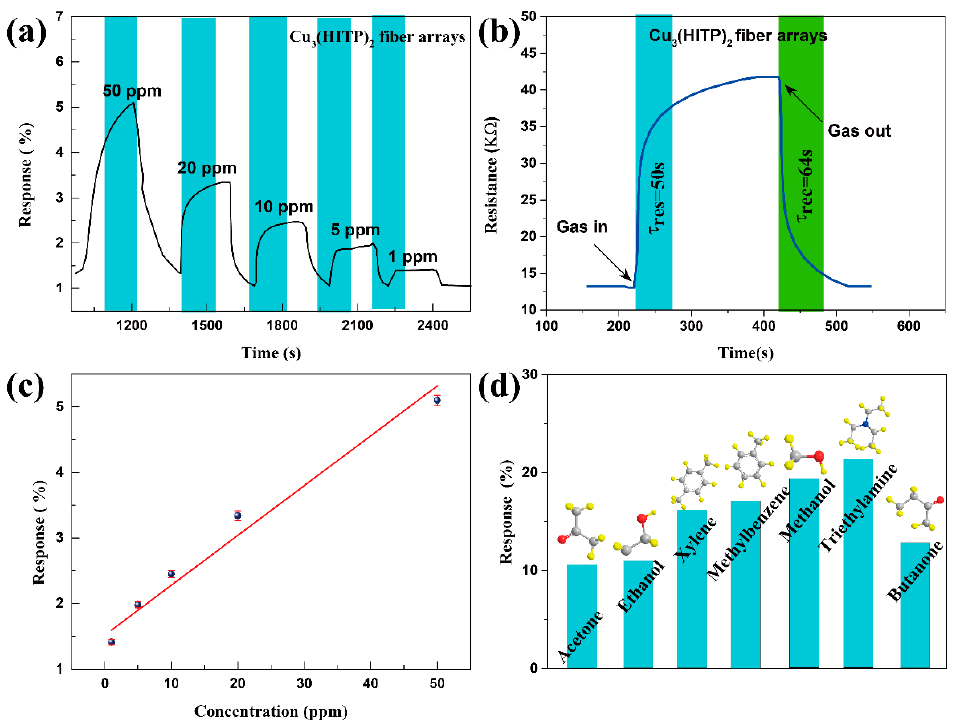
Figure 6. ( a ) Relative responses of a Cu 3 (HITP) 2 device to 1, 5, 10, 20, and 50 ppm ethanol. ( b ) Re- sponse and recovery times defined for Cu 3 (HITP) 2 fiber arrays sensing 20 ppm of ethanol. ( c ) Device response as a function of ethanol concentration (R 2 = 0.96). ( d ) Sensing response of Cu 3 (HITP) 2 fiber array sensors to 200 ppm of acetone, ethanol, xylene, toluene, methylbenzene, methanol, triethyla- mine, and butanone at room temperature.